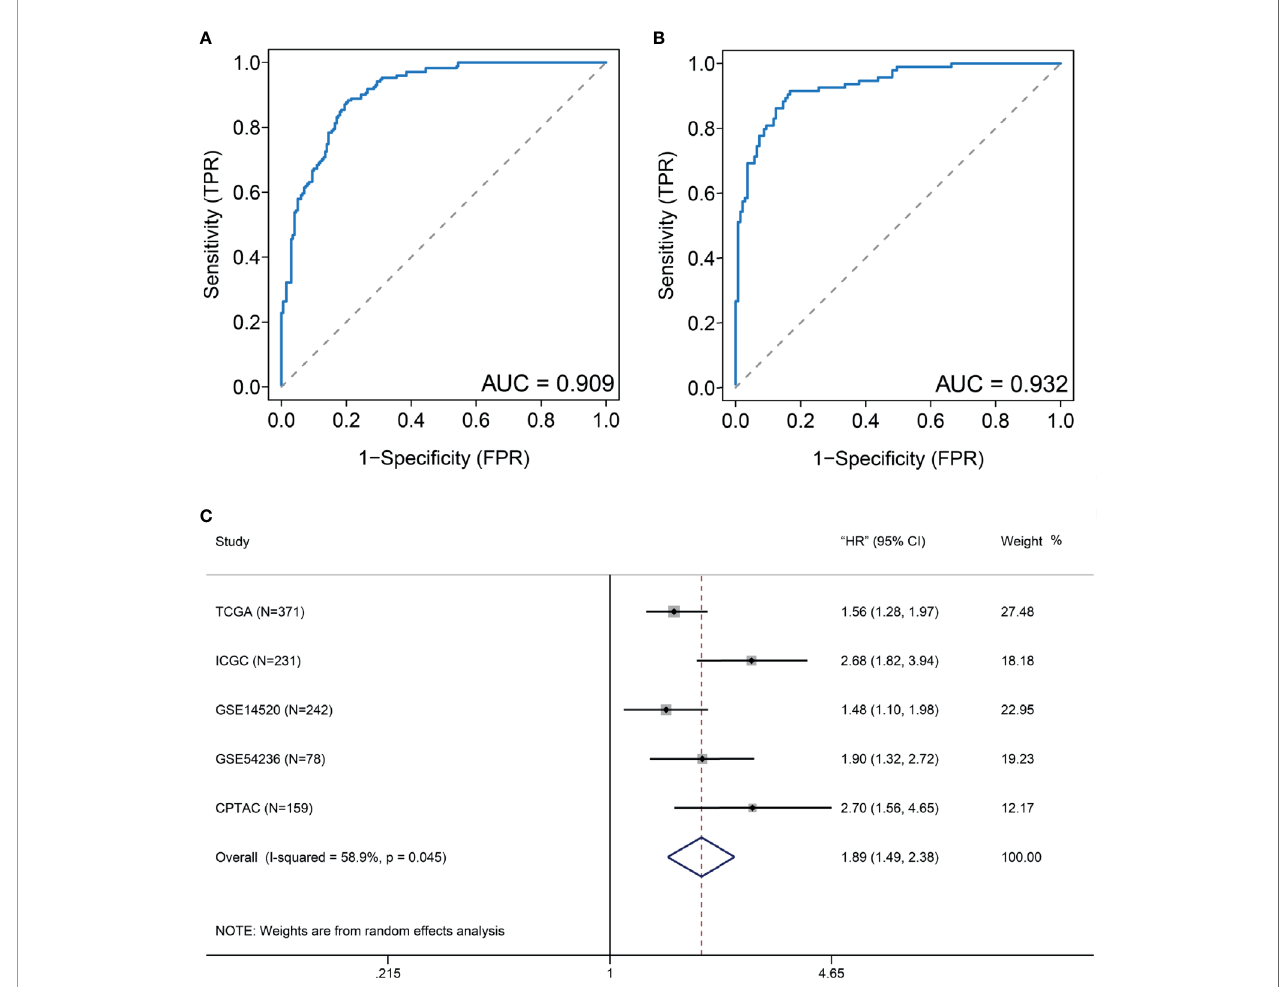
FIGURE 5 | DDR-subtype development and validation. Receiver operating characteristic curve (ROC) analyses of DDR signature to evaluate its performance in TCGA (A) and ICGC (B) datasets. (C) Forest plots show that a high DDR signature score is correlated with inferior overall survival based on fi ve